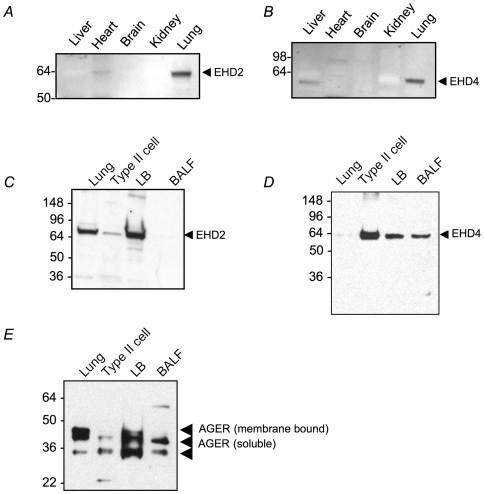
Western blot for LB proteome proteins.Samples were normalized to protein content. Distribution of (A) EHD2 and (B) EHD4 in mouse tissues. Distribution of (C) EHD2, (D) EHD4 and (E) AGER in lung homogenates, type II cells, isolated LBs and BALF.